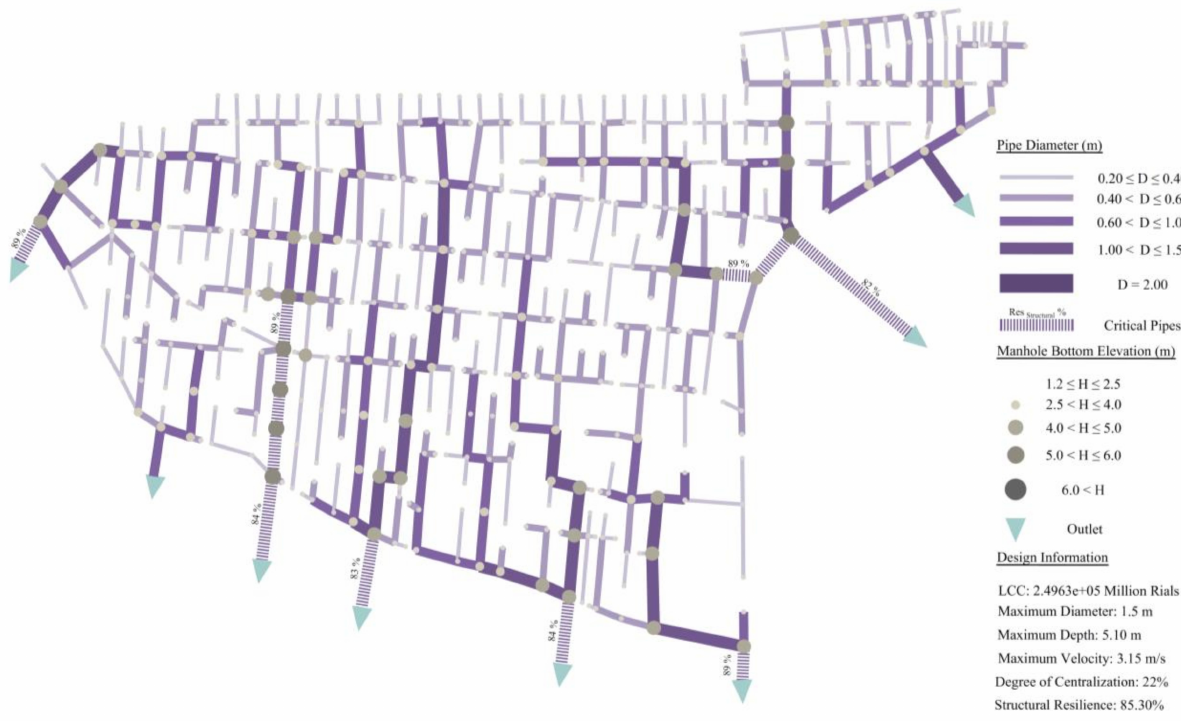
Figure 7. Design 1 (life cycle cost (LCC) = 249,630 M. Rials and degree of centralization (DC) =